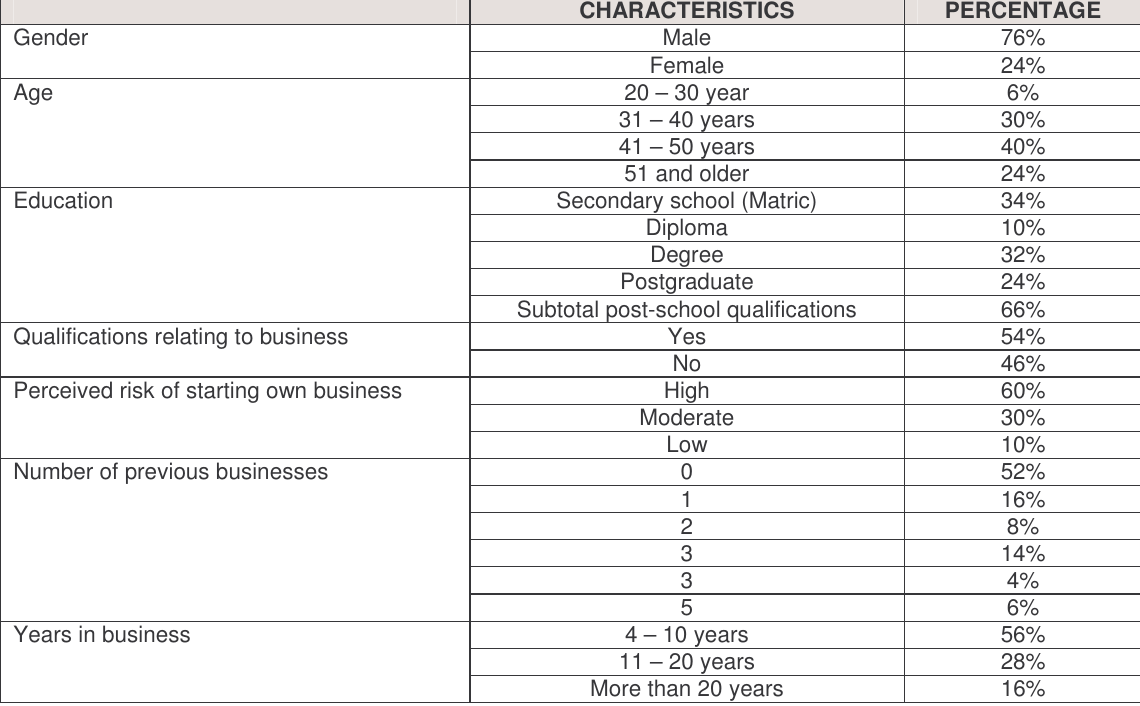
CHARACTERISTICS